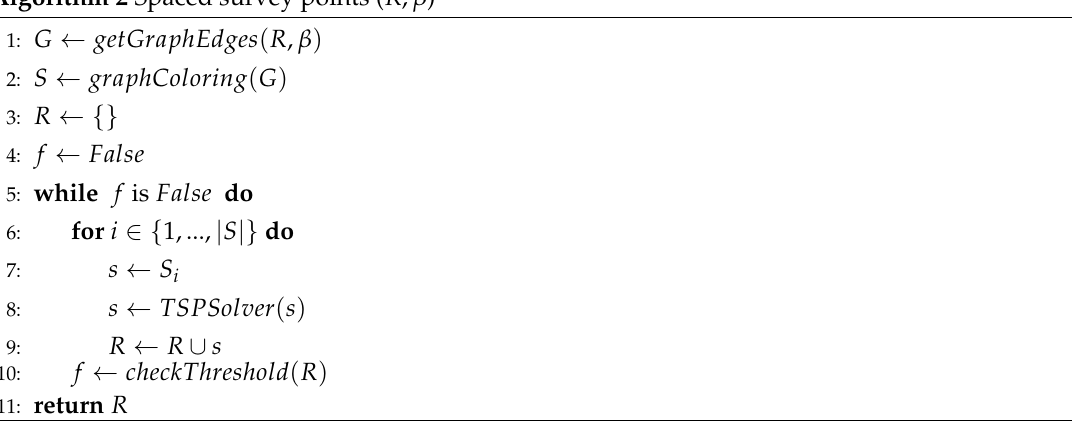
Algorithm 2 Spaced survey points ( R , β